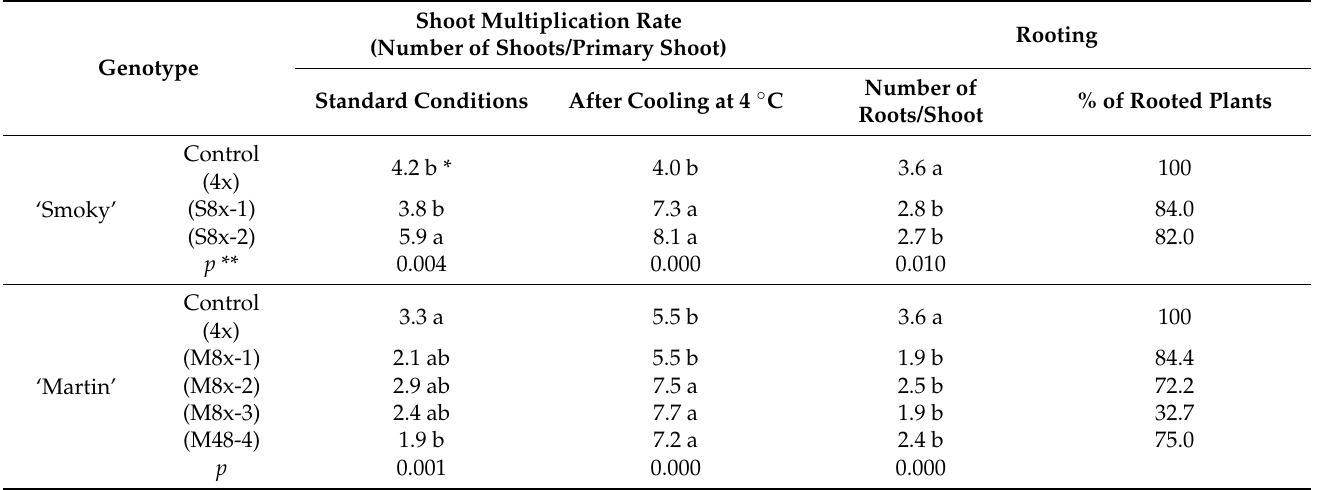
Table 3. Comparison of Amelanchier alnifolia cvs. ‘Smoky’ and ‘Martin’ tetraploids (4x) and octoploid clones (8x) in terms of the efficiency of shoot multiplication and rooting of plants in vitro.